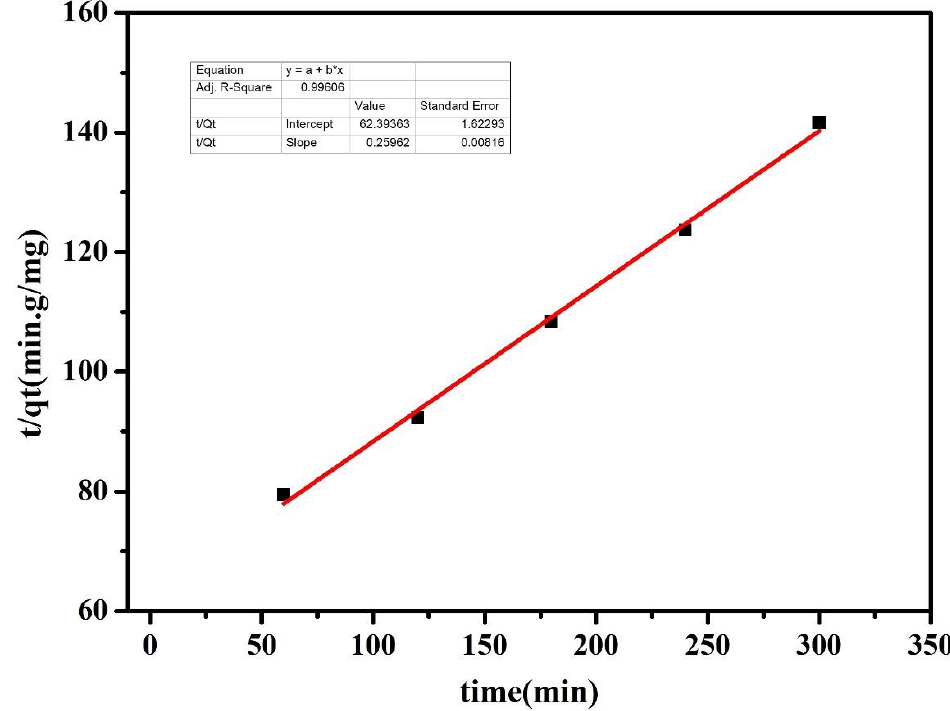
Figure 9. Plot of the pseudo second order kinetics of Ba 0.54 Na 0.46 Nb 1.29 W 0.37 O 5 through the adsorption of the methylene blue.